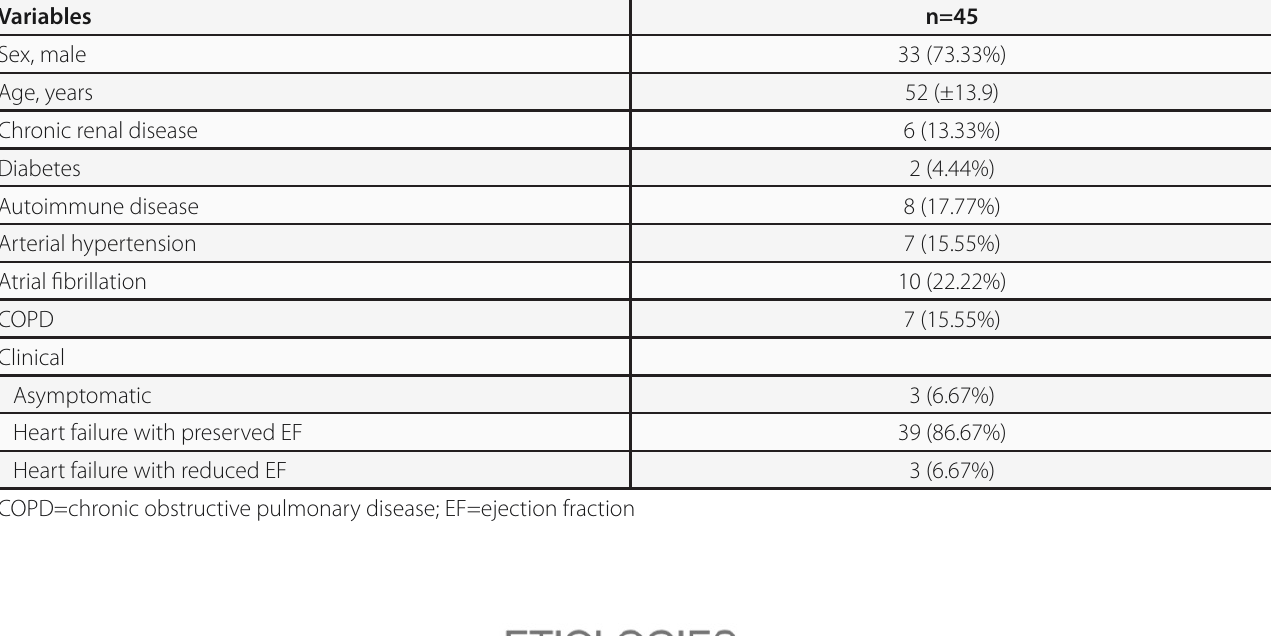
Table 1. Demographic characteristics and preoperative comorbidities.